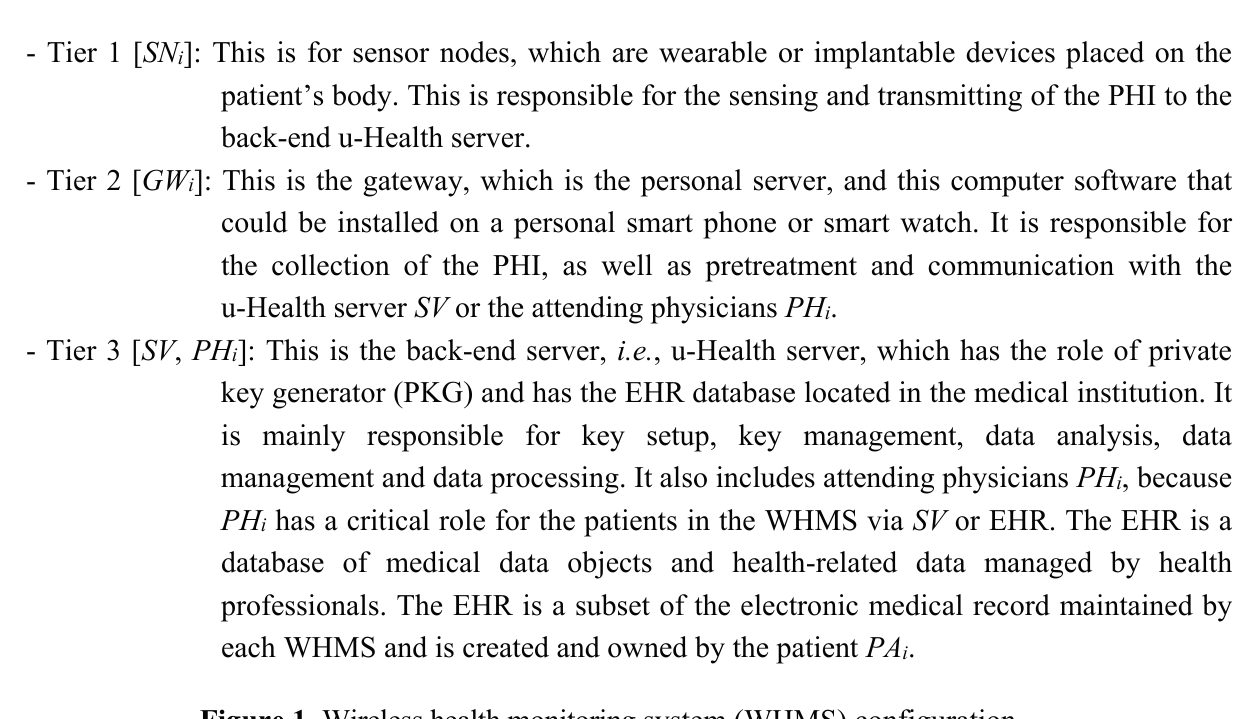
Figure 1. Wireless health monitoring system (WHMS)